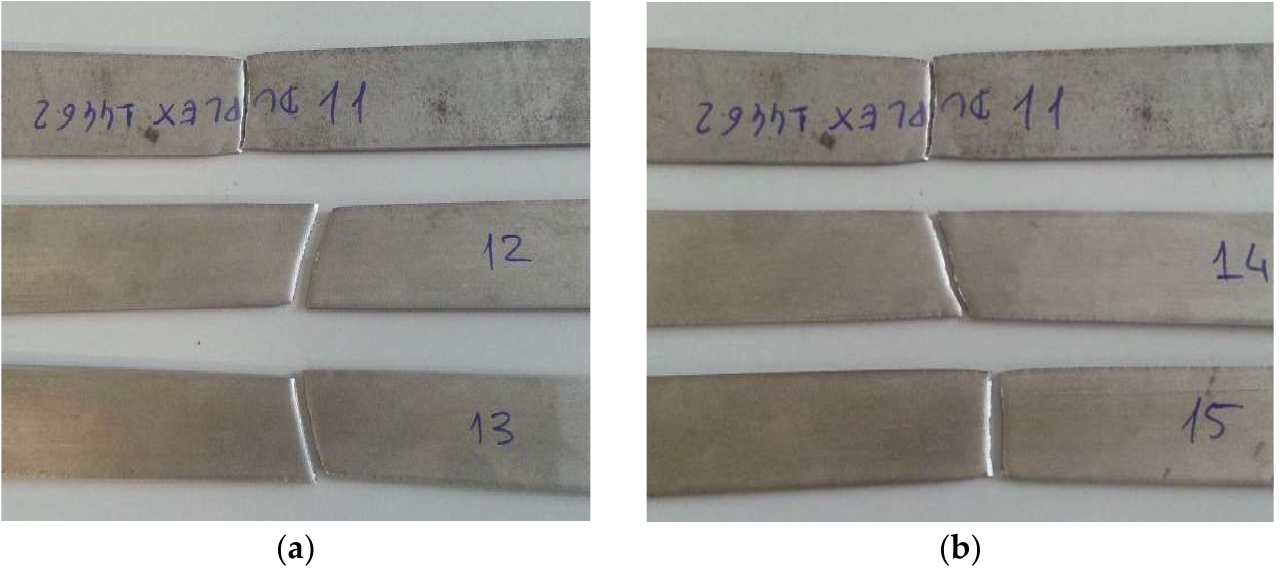
Figure 15. Duplex 14462 samples after three weeks ( a ) and three months ( b ) of being subjected to the tensile test.